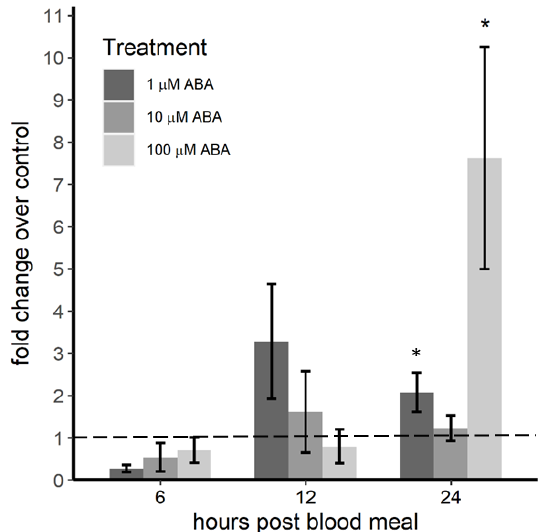
Figure 6. Nos expression in P. y. yoelii 17XNL-infected A. stephensi derived from ABA-treated larvae was induced at 24 h post-infection. Transcript levels were quantified by qRT-PCR using the 2 – ∆∆ Ct method; untreated controls (0 µ M ABA) were set to 1 (dashed line). There were no significant changes in nos expression relative to controls at 6 h ( F = 0.991, p = 0.483) or 12 h ( F = 1.159, p = 0.390) post-infection in females derived from ABA-treated larvae. However, nos expression was increased compared to controls at 24 h ( F = 4.795, p = 0.014) in A. stephensi derived from larvae treated with 1 µ M ABA (Tukey p = 0.041) and 100 µ M ABA (Tukey p = 0.016) but not 10 µ M ABA (Tukey p > 0.05). Data are shown as mean ± SE across three biological replicates. Data were analyzed by ANOVA. * p 0.05.